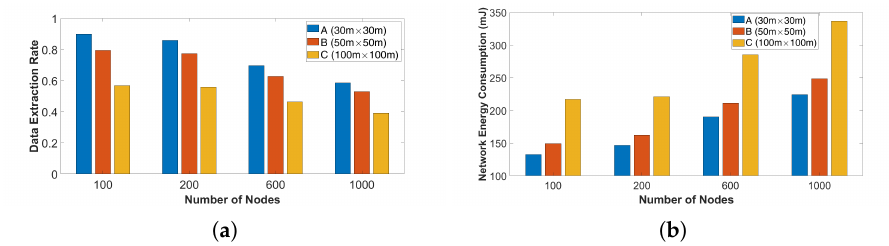
Figure 5. Log-normal shadowing model in the urban environment: ( a ) DER as a function of the number of nodes; and ( b ) NEC as a function of the number of nodes.